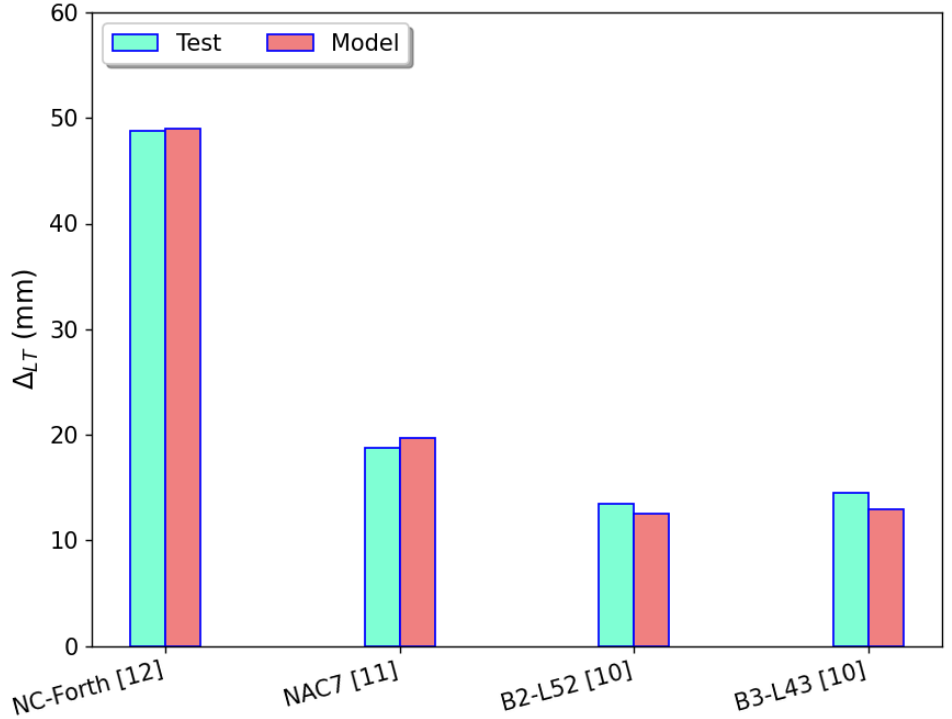
Figure 12. Long-Term Deflection- Experimental [10–12] vs. Present Work.